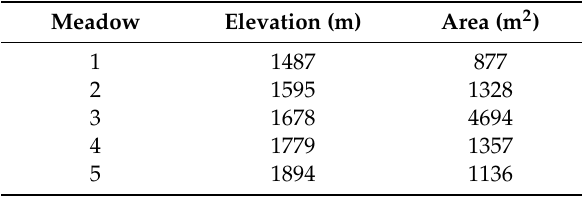
Table 1. Elevation and area of meadow